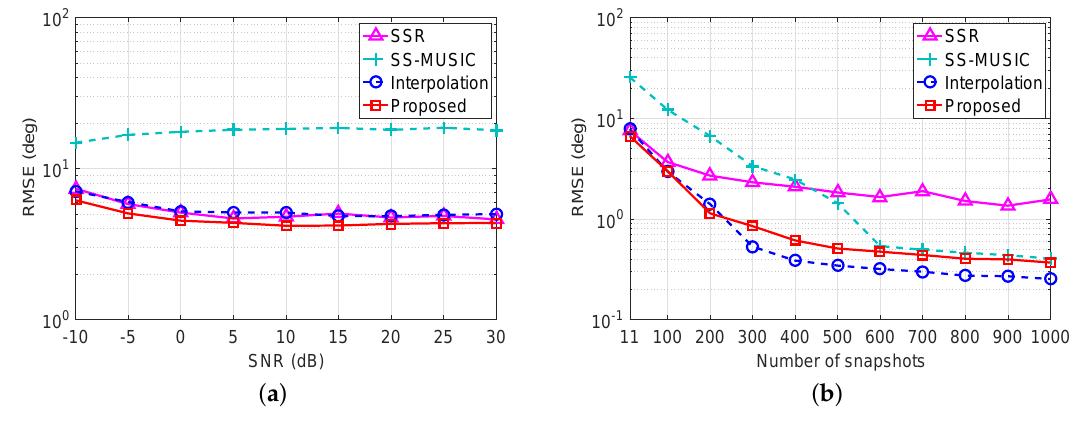
Figure 8. RMSE performance comparison when there are more sources than sensors. ( a ) RMSE versus SNR with L = 50; ( b ) RMSE versus the number of snapshots with SNR = 0 dB.